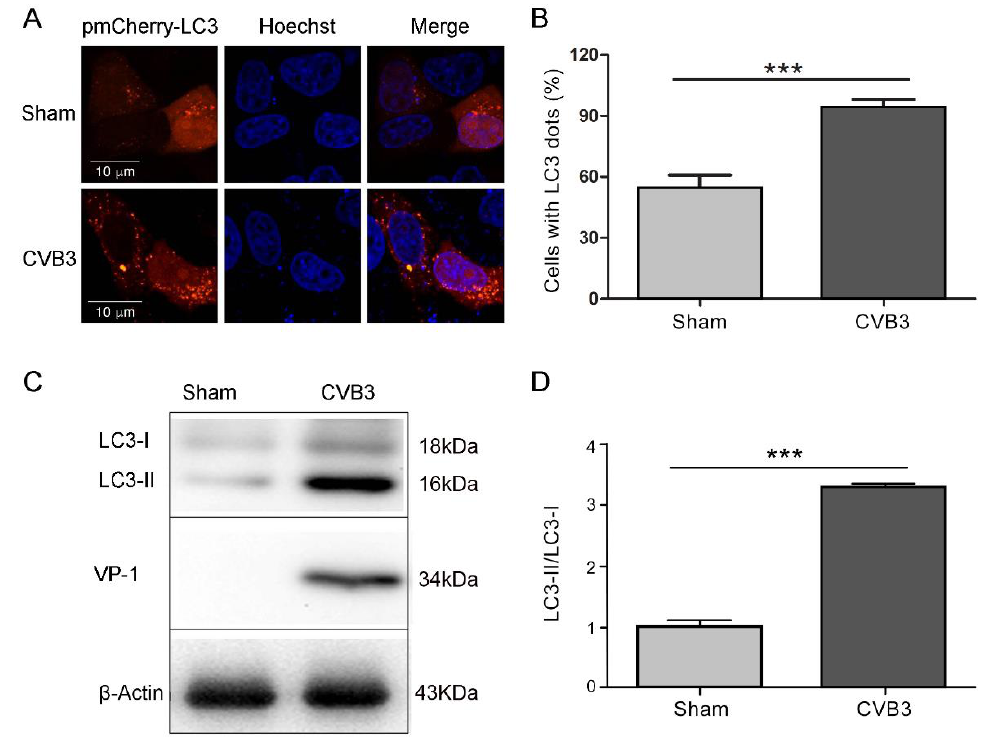
Figure 1. Coxsackievirus B 3 (CVB3) induces autophagy in HeLa cells. HeLa cells were infected with CVB3 (MOI = 10) for 7 h. Cells cultured in Dulbecco's Modified Eagle Medium (DMEM) without CVB3 infection were taken as control. ( A ) Cells were observed by confocal microscope (×600); ( B ) cells with LC3 dots were counted over the LC3-expressing cells. *** p < 0.01. Data were derived from 100 cells in each sample; ( C ) VP1 and LC3 were detected by Western blotting; ( D ) the ratio of LC3-II/LC3-I was calculated according to the results of Western blots. n = 4. Experiment was repeated three times. Representative images were presented.